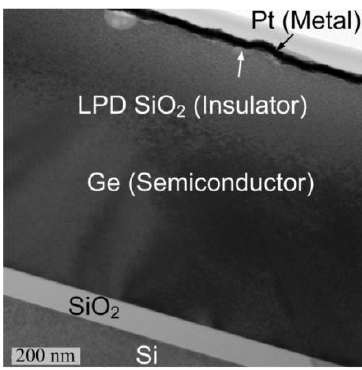
Figure 20. The TEM photograph of the 0.8  m thick-Ge GOI MIS photodetector. The low-temperature LPD SiO was formed on the thin-film Ge instead of the unstable GeO 2